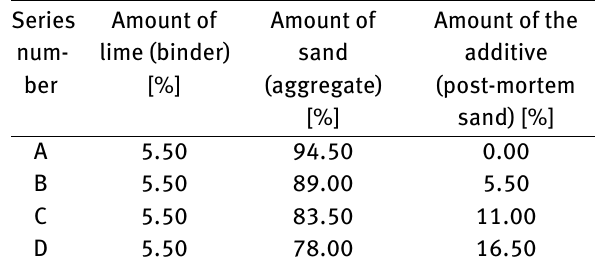
Table 1: Summary of functional features of high reactive burnt lime.